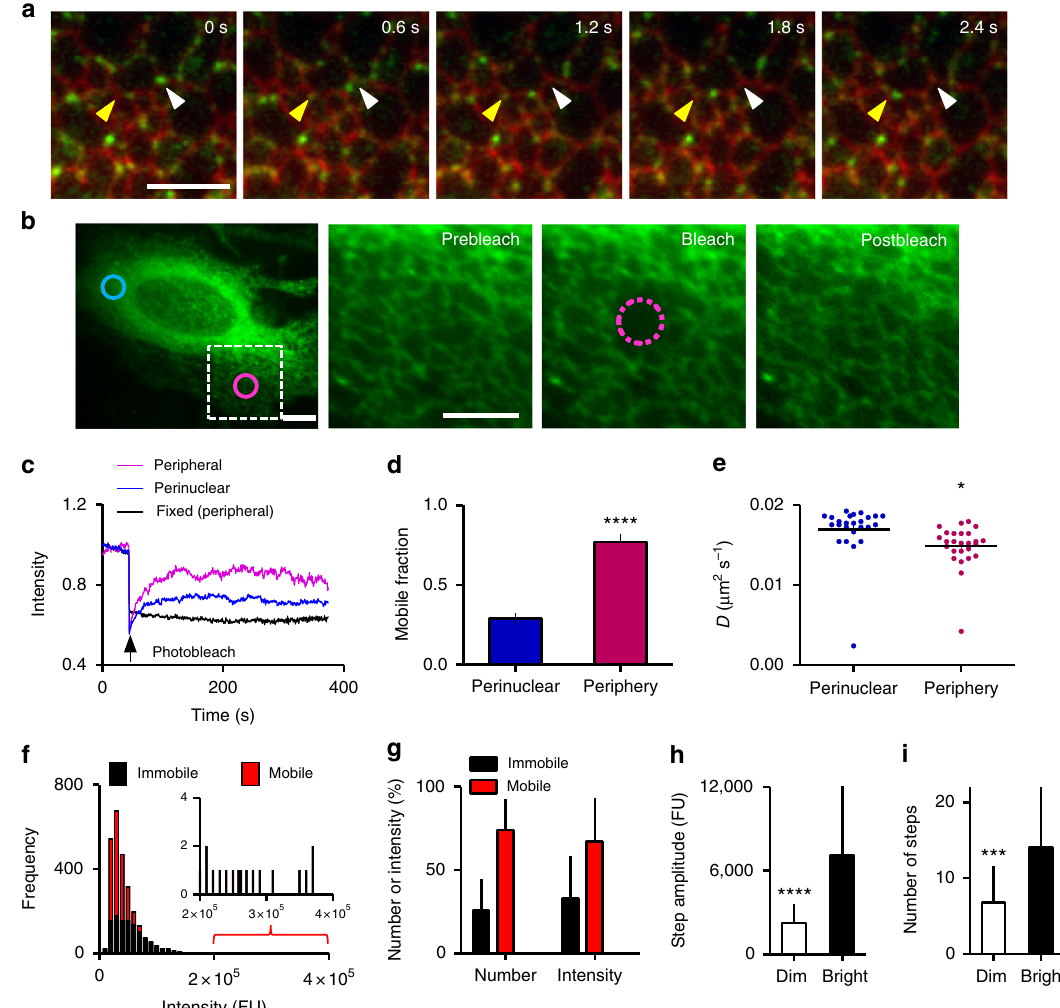
Fig. 2 IP 3 Rs form mobile and immobile puncta. a Time-lapse TIRFM images (0.6-s intervals) of EGFP-IP 3 R1 in cells expressing mCherry-ER. Track of a single particle, with the fi rst and last positions shown by white and yellow arrows, respectively. Scale bar = 5 µ m. b Representative epi fl uorescence image of an EGFP-IP 3 R1 HeLa cell with perinuclear (blue) and peripheral (magenta) regions highlighted for FRAP analysis (circular bleached area, radius = 1.84 μ m). The boxed area is enlarged to show pre- and post-bleach (after 120 s) images of the peripheral region. Scale bars = 5 µ m. c Normalized fl uorescence intensities recorded from peripheral or perinuclear regions in a typical FRAP experiment with live and fi xed EGFP-IP 3 R1 HeLa cells. d , e Summary results show mobile fractions ( M f , mean ± SEM) ( d ) and diffusion coef fi cients ( D , mean and all values) ( e ) for perinuclear (25 cells) and peripheral regions (26 cells). **** P < 0.0001, * P < 0.05, two-tailed Student ’ s t -test. f Distribution of fl uorescence intensities for individual mobile and immobile puncta. Inset shows distribution for the brightest immobile puncta. g Relative numbers of mobile and immobile puncta, and distribution of fl uorescence between them (%). Results ( f , g ) are from time-lapse TIRFM images of 10 cells (mean ± SD). h , i Analysis of bleaching steps of brightest and dimmest puncta in fi xed cells was used to determine the step amplitude ( h ) and number of steps ( i ) for each punctum (Supplementary Fig. 8). Mean ± SD, with 23 – 25